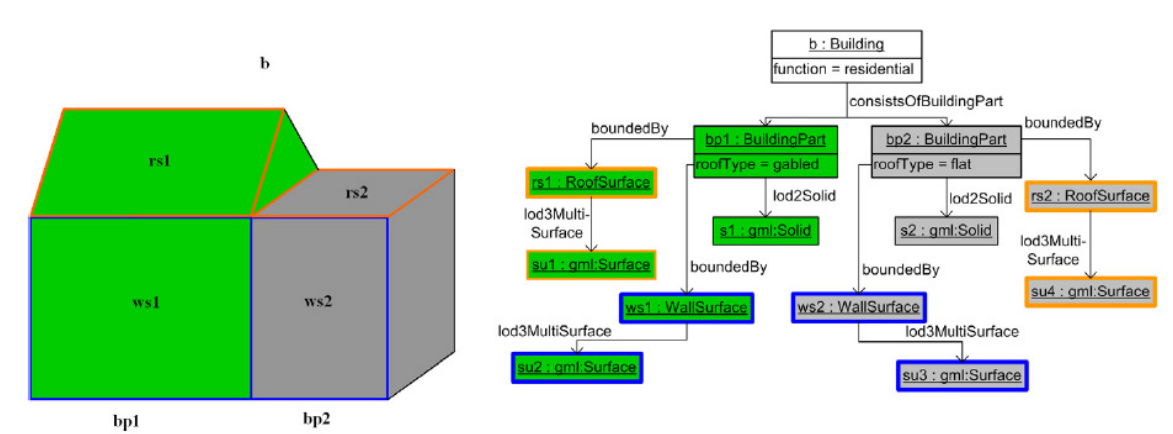
Figure 1: LoD2 building illustration: CityGML feature structure as UML instance diagram (taken from (Gr¨oger and Pl¨umer, 2012))